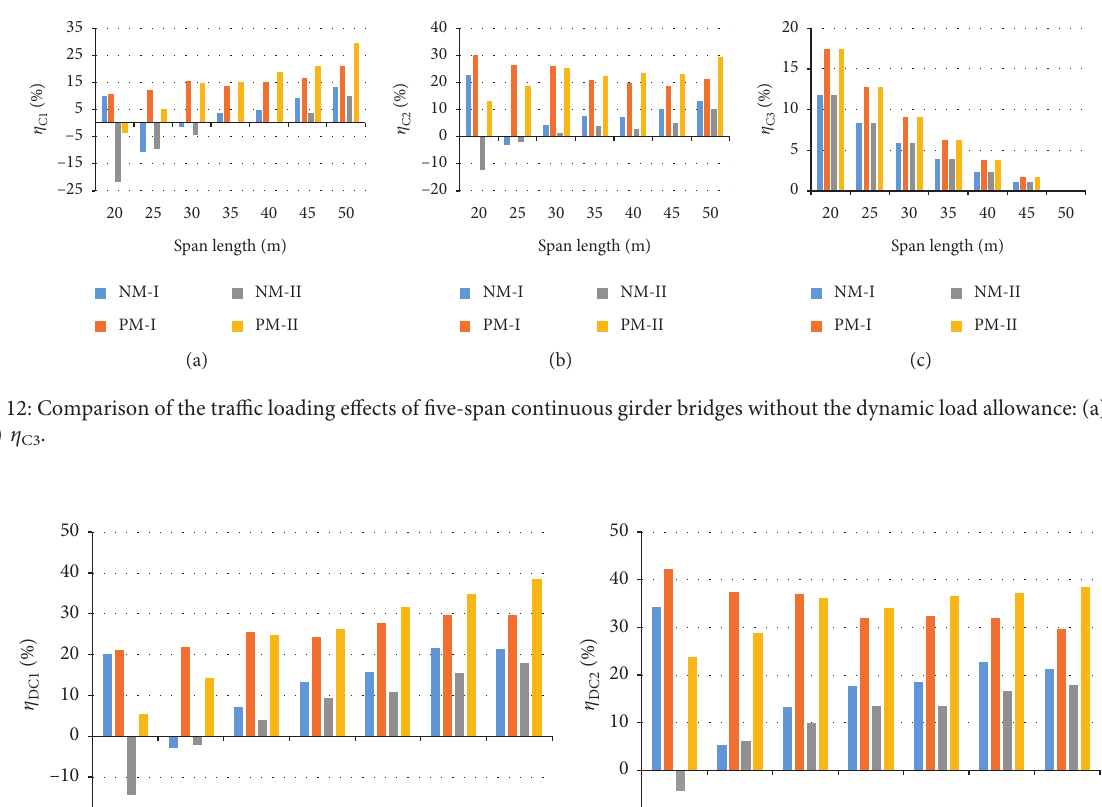
Figure 11: Comparison of the traffic loading effects of four-span continuous girder bridges with dynamic load allowance: (a) η η DC2 .